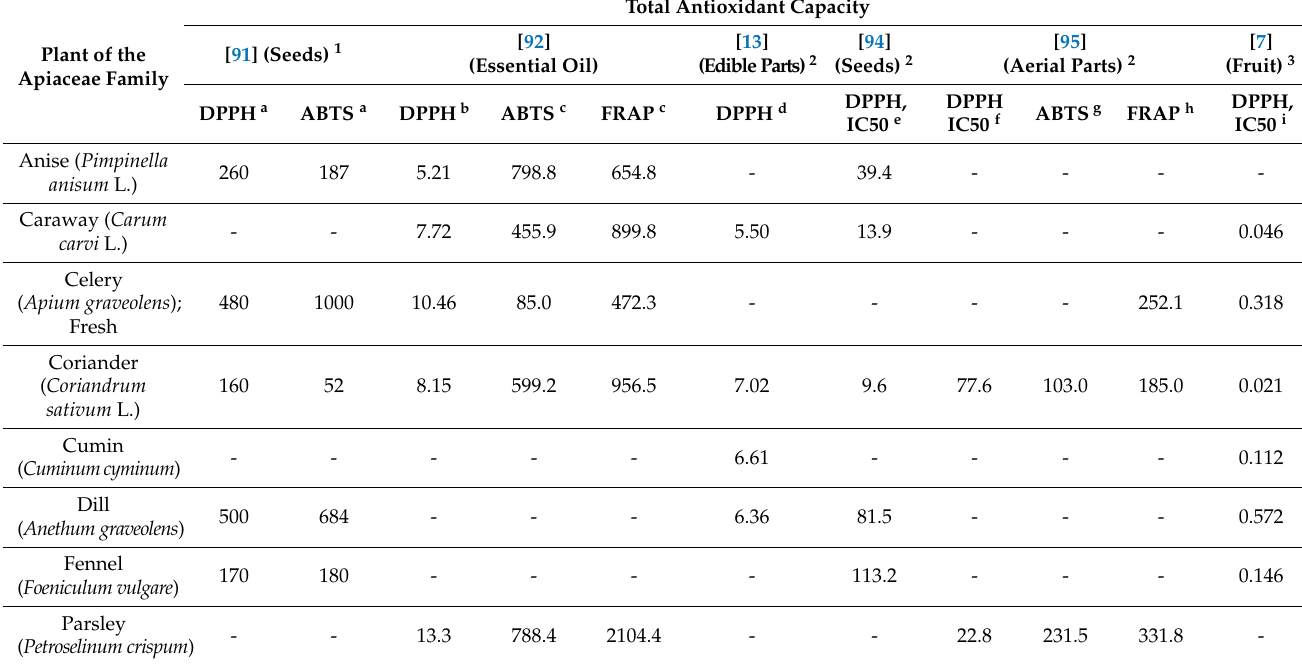
Table 5. Antioxidant capacity of Apiaceae